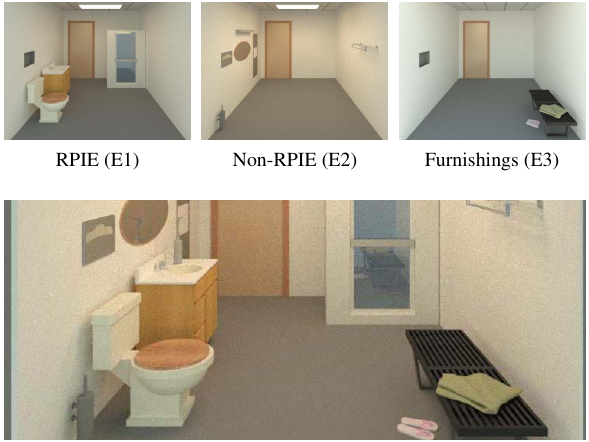
Figure 12. The room shown in gray in floor plan (a) has been concealed in floor plan (b)